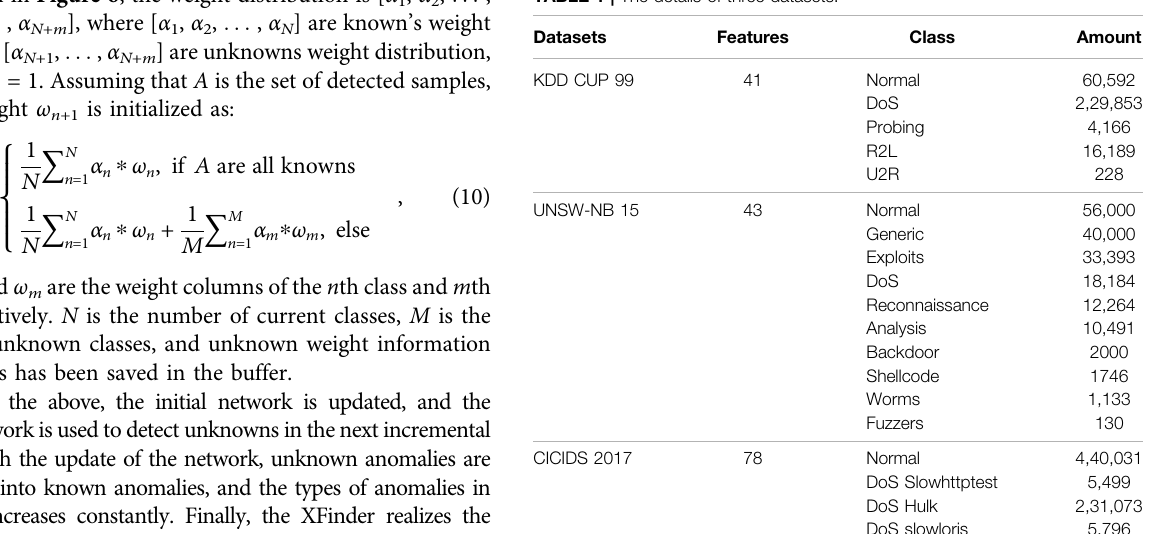
TABLE 1 | The details of three